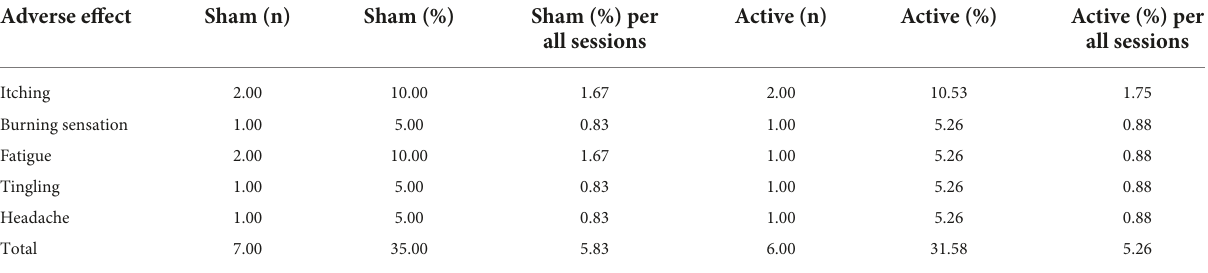
TABLE 8 Adverse effects as reported in the